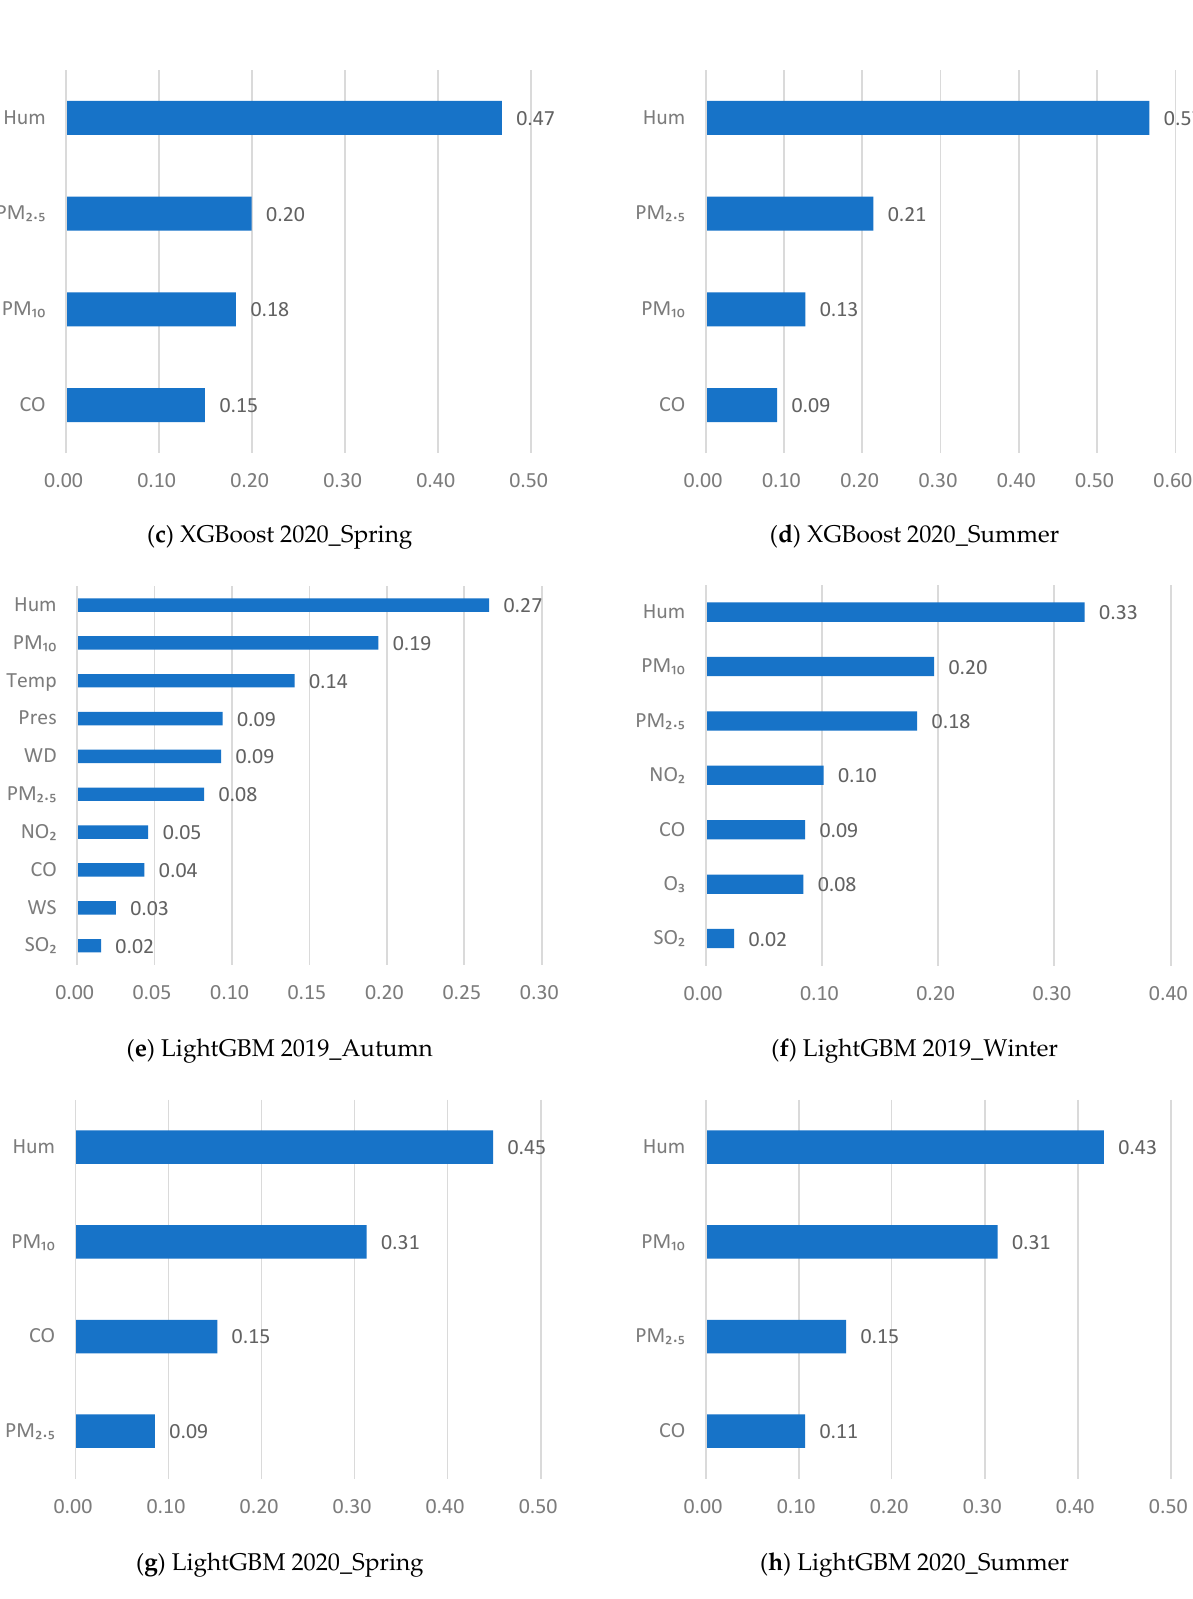
Figure 4. Feature selection results of XGBoost and LightGBM in each season. ( a – c ) and ( d ) are the feature selection results of XGBoost in 2019_Autumn, 2019_Winter, 2020_Spring, and 2020_Summer, respectively. ( e – h ) show the feature selection results of LightGBM in 2019_Autumn, 2019_Win-